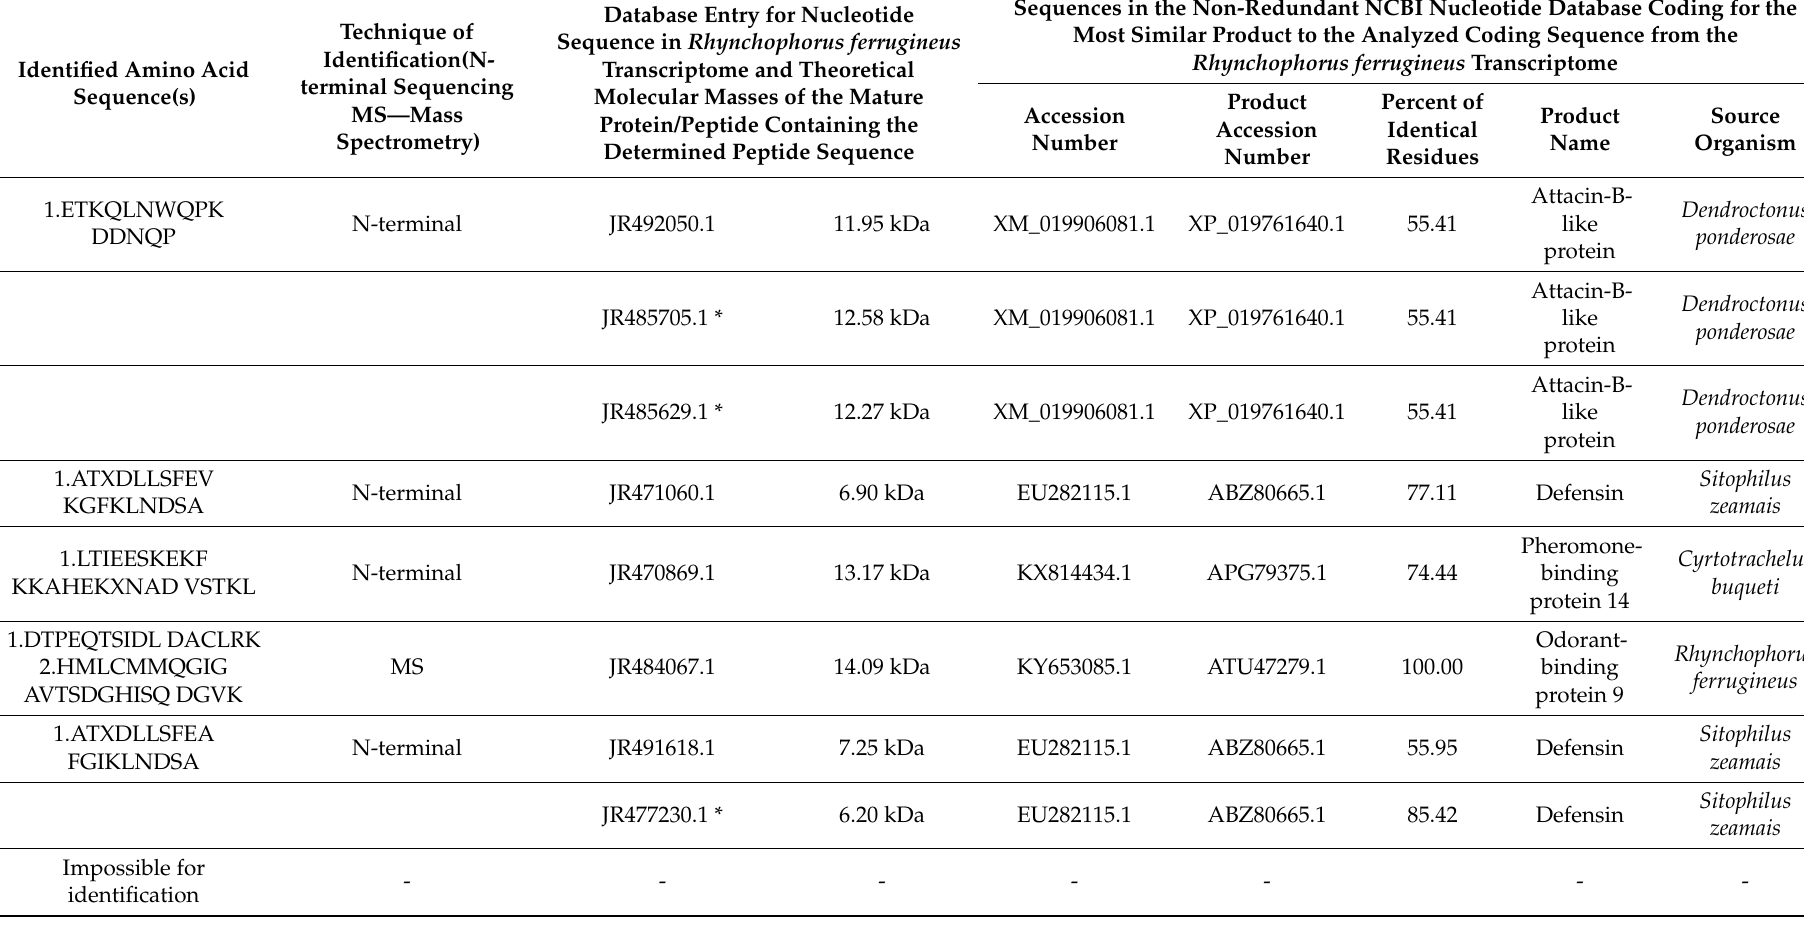
Table 1. Amino acid sequences of bactericidal proteins and peptides isolated from Rhynchophorus ferrugineus immunized hemolymph and essential bioinformatic parameters of their putative coding